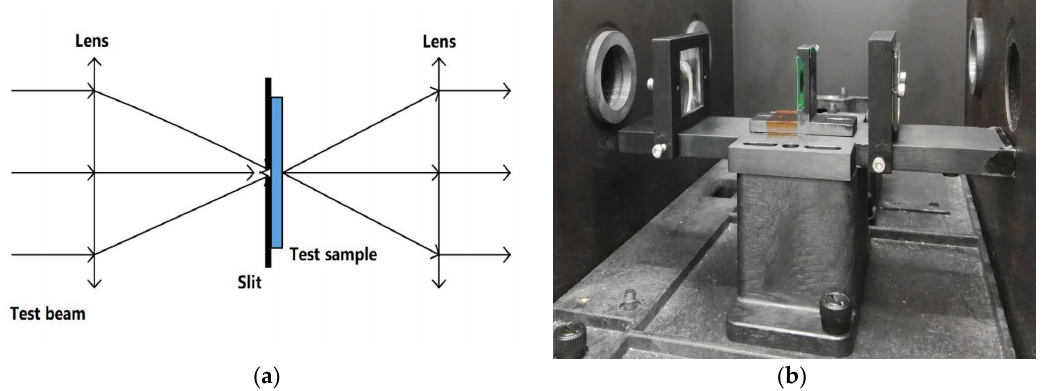
Figure 9. The micro-spot test method. ( a ) The measurement principle and ( b ) the developed test accessory for a Lambda1050 spectrophotometer.